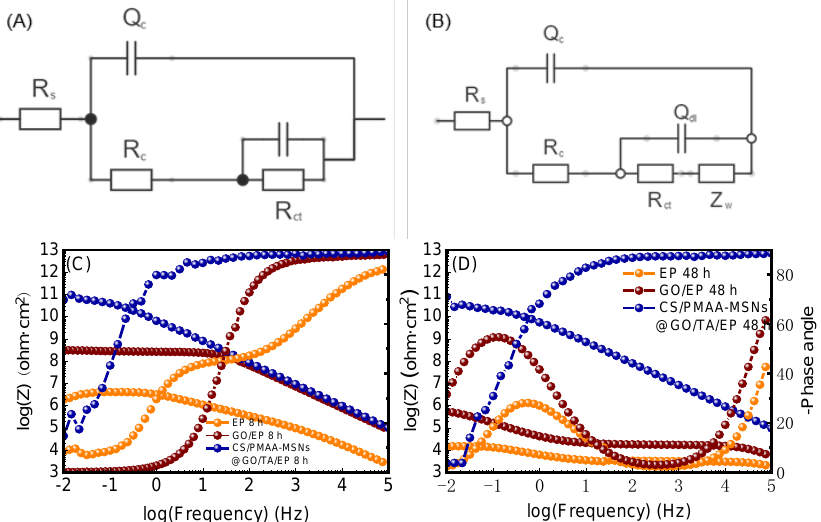
Figure 11. ( A , B ) Equivalent circuit model for fitting experimental impedance data; ( C ) Bode dia- grams of EP, GO/EP, CS/PMAA-MSNs@GO/TA/EP immersed for 8 h and ( D ) 48 h. Table 2. The impedance values at 0.01 Hz, and breakpoint frequencies of EP, GO/EP, and CS/PMAA-MSNs@GO/TA/EP